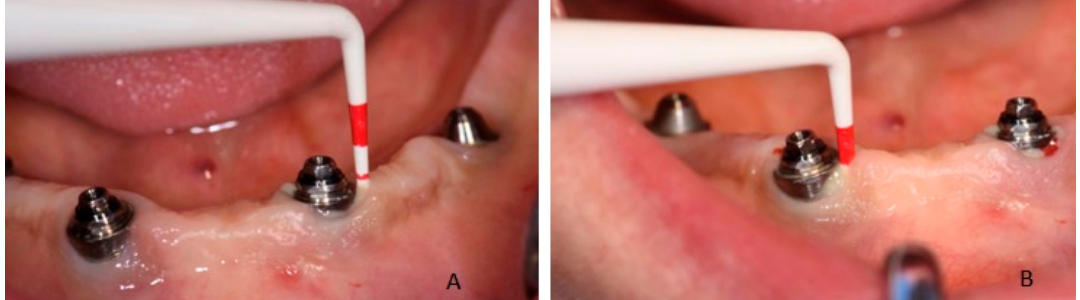
Figure 1. Probing of dental implant area and suppuration in patient during the first visit: ( A ) in 3.2 position and ( B ) in 4.2 position.